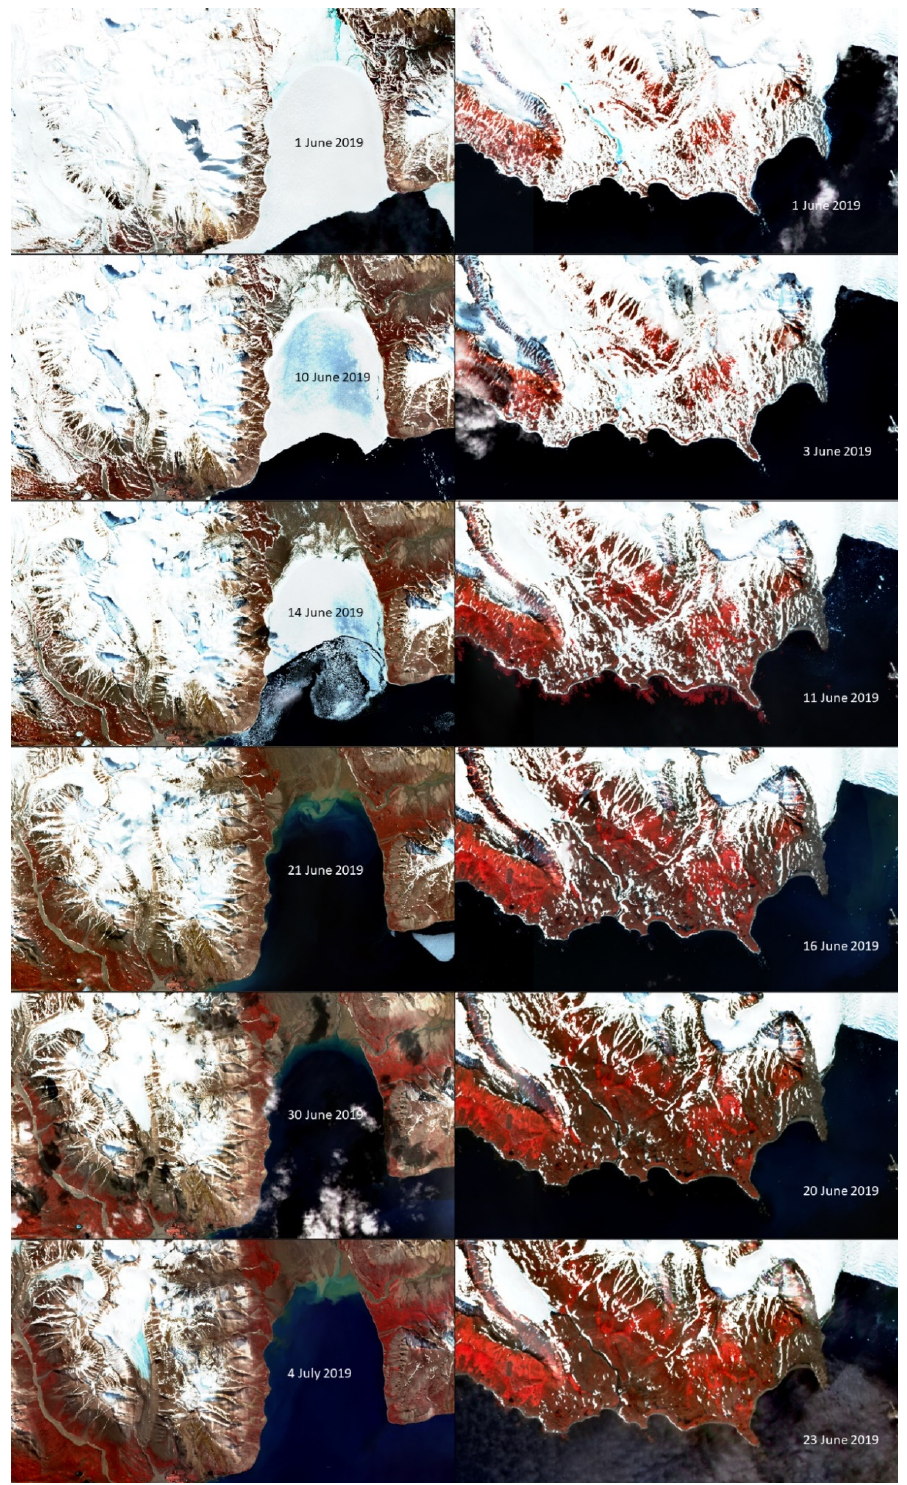
Figure 8. Sentinel satellite images illustrating retreat of snow cover on both study locations several weeks before the sampling has been made.